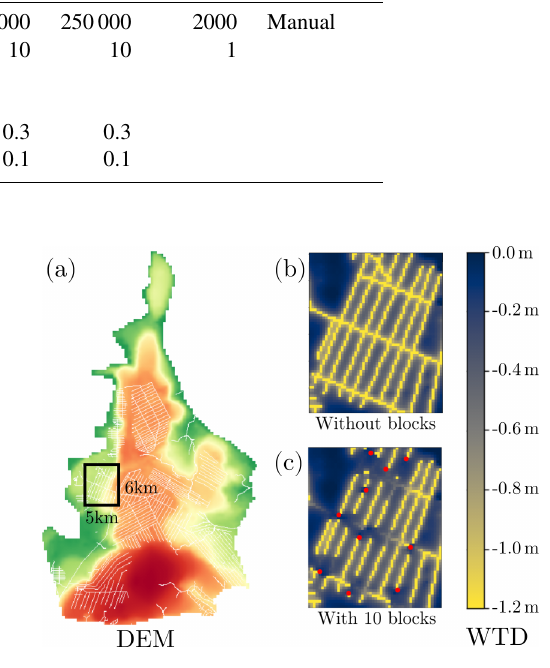
Table 2. Block locating methods and their parameters. The values of the parameters were decided empirically. Definition SA GA SO Random Rule-based Number of iterations or generations 6000 6000 250000 2000 Manual Number of processors 1 10 10 1 Initial temperature 300 Final temperature 1 Single point crossover mating prob. 0.3 0.3 Mutation probability 0.1 0.1